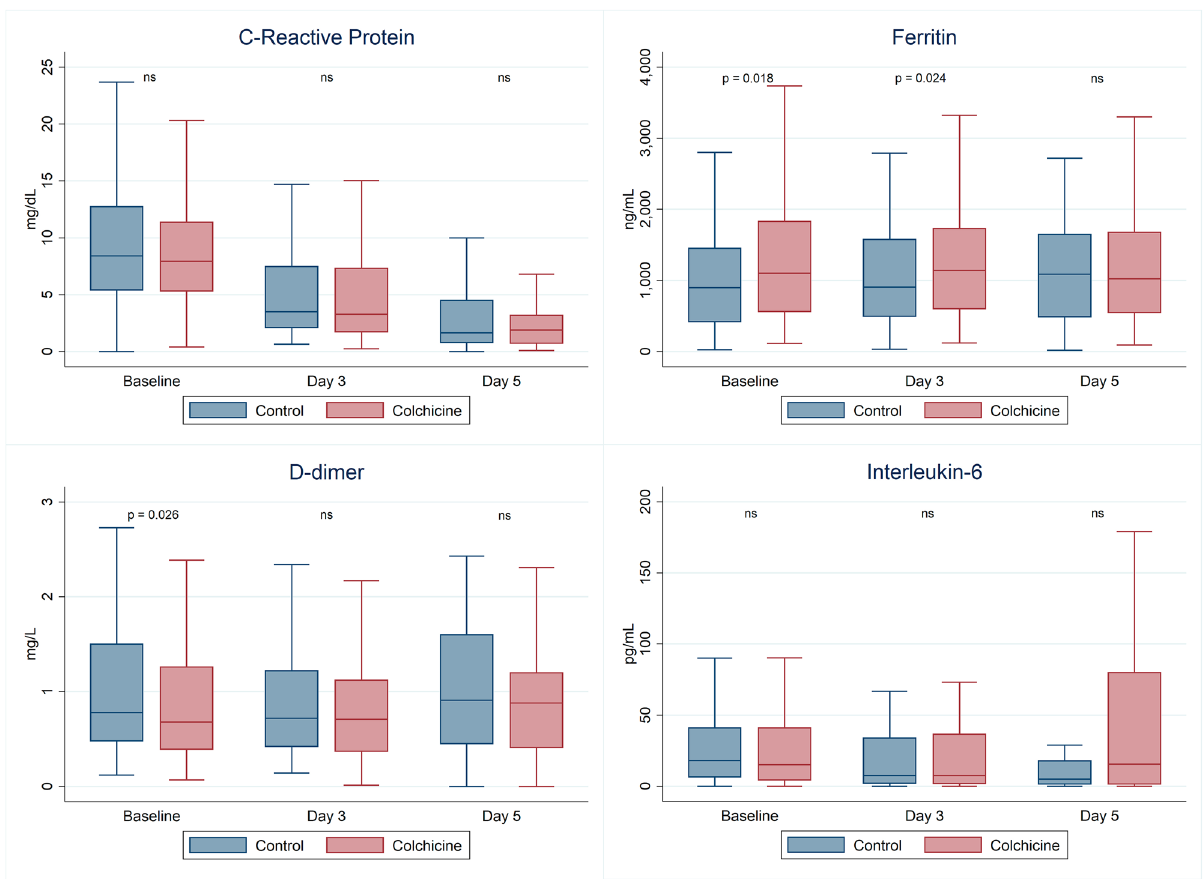
Figure 3. Inflammatory markers. Distribution of inflammatory markers in each group and over time are presented using box-and-whisker plots. Significant comparisons are